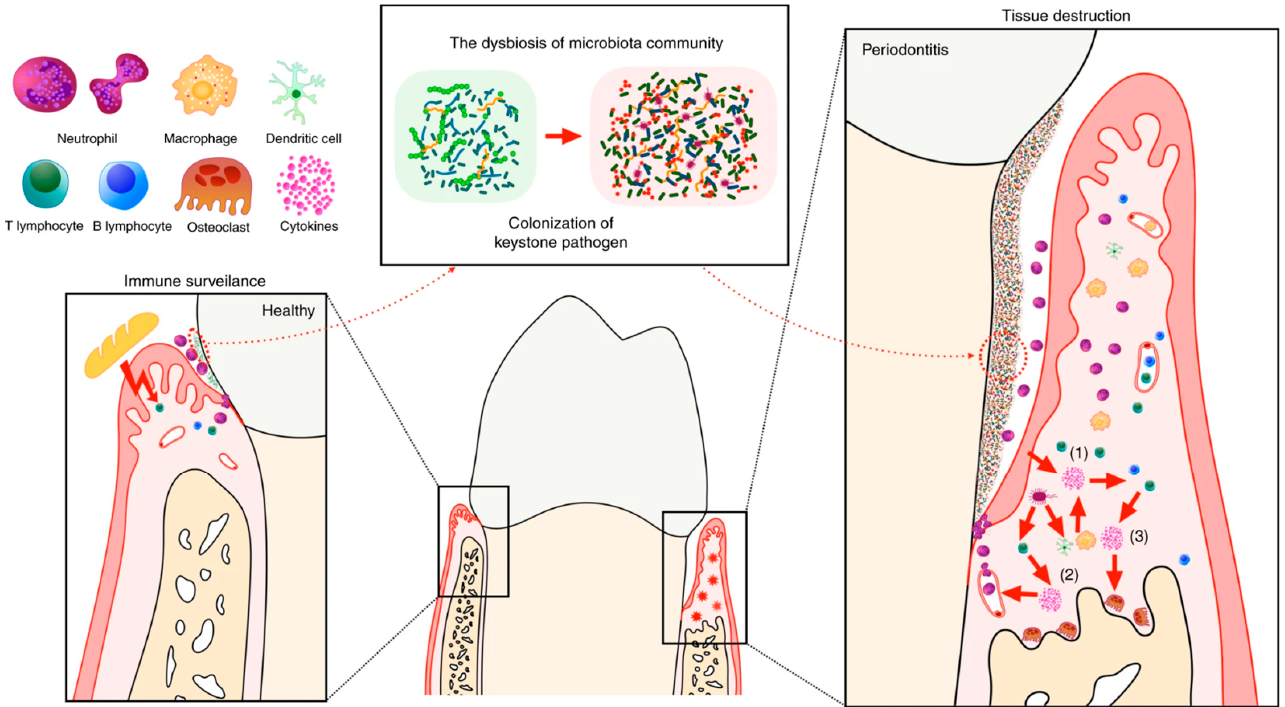
Figure 2. Periodontal tissue in a healthy state and the pathogenesis of chronic periodontitis (CP). In a healthy state, there is a balance between microbial changes and host immune response, with infiltrating neutrophils and resident immune cells in the gingival sulcus, performing immune surveillance. Colonization of periodontal keystone pathogens over ‐ activates the host immune response, leading to the amplification of the proinflammatory cytokine cascade. The first wave of cytokine production is caused by the interaction of the microbiota with all host cells (1), and it primarily contributes to the amplifying of the proinflammatory cytokine cascade and the recruitment, activation, and differentiation of certain immune cells. After being stimulated by the microbiota, mononuclear phagocytes and antigen ‐ presenting cells release a series of cytokines (2) that are intimately linked to the differentiation of a certain subgroup of lymphocytes. Each of these cell subsets secretes a specific pattern of cytokines, which may function as a direct effector or a positive ‐ feedback factor (3) and ultimately result in potential tissue destruction. Reproduced with permission from Pan et al. [69] under Creative Common License.